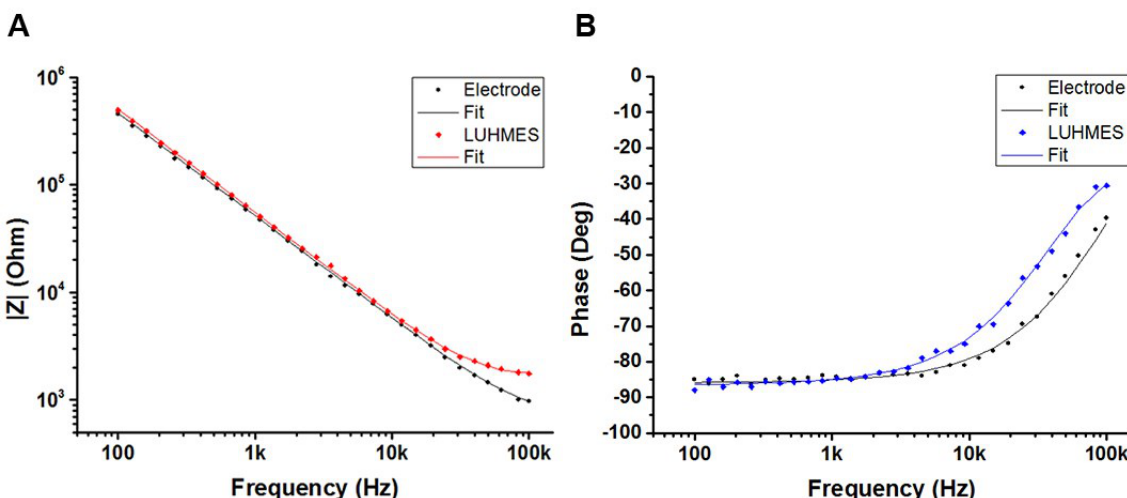
Figure 7. Example of typical Bode plots for an electrode and the same electrode 48 h after seeding of 60,000 LUHMES cells/cm 2 : A ) impedance magnitude and B ) phase angle. Solid lines show the nonlinear least squares fit of the experimental data to the equivalent circuit models of Fig.